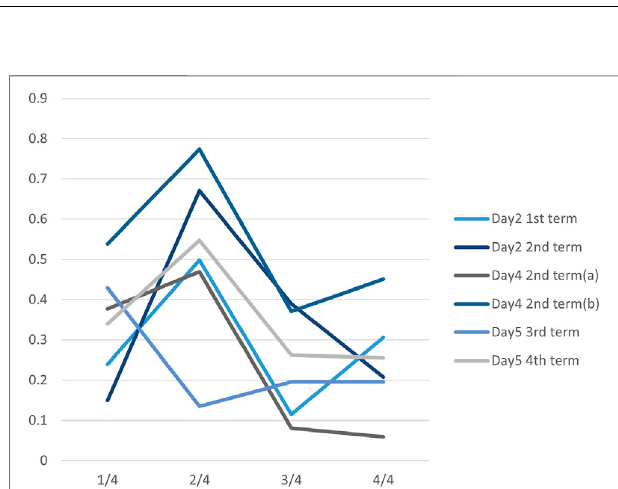
FIGURE 5 | The ratio of various tasks to the total daily work time of each worker.